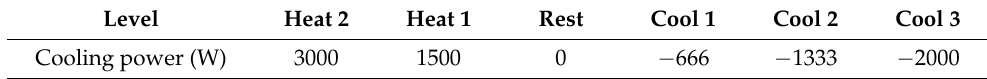
Table 1. Cooling-heating power options.